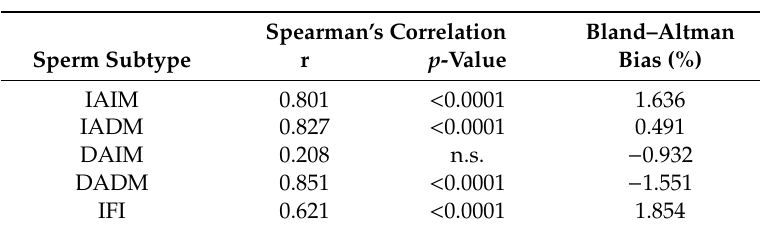
Table 1. Comparison between the percentages of each subtype based on acrosomal and plasma membrane integrity given by manual analysis and by the Sperm Functionality Module included in OpenCASA. Both methods were compared using the Spearman correlation test and the Bland–Altman test.